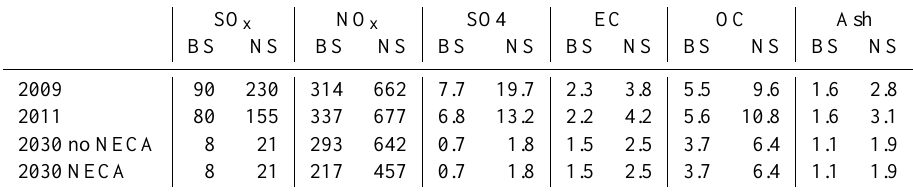
Table 1. Emissions from shipping in the Baltic (BS) and North (NS) seas in Gg yr − 1 . SO x emissions as SO 2 and NO x emissions as NO 2 . SO x NO x SO4 EC OC Ash BS NS BS NS BS NS BS NS BS NS BS